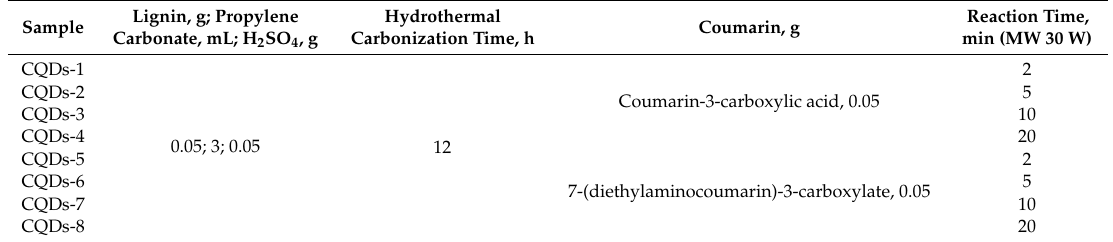
Table 3. Synthesis parameters of coumarin-modified